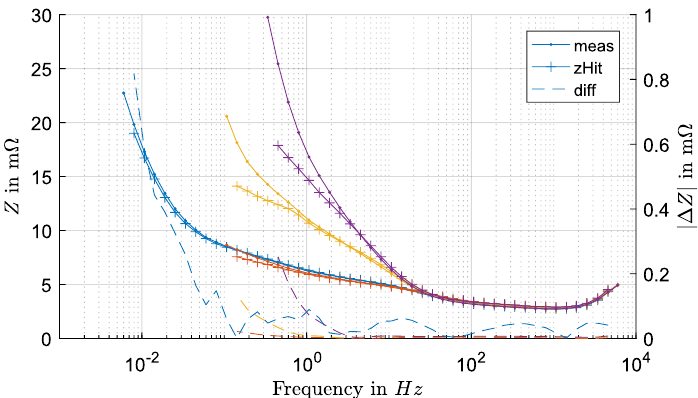
Figure 6. Impedance spectra measured on TC 1 of hard AK3.4 at the end of the first cycling phase (after 15FCE) with charging